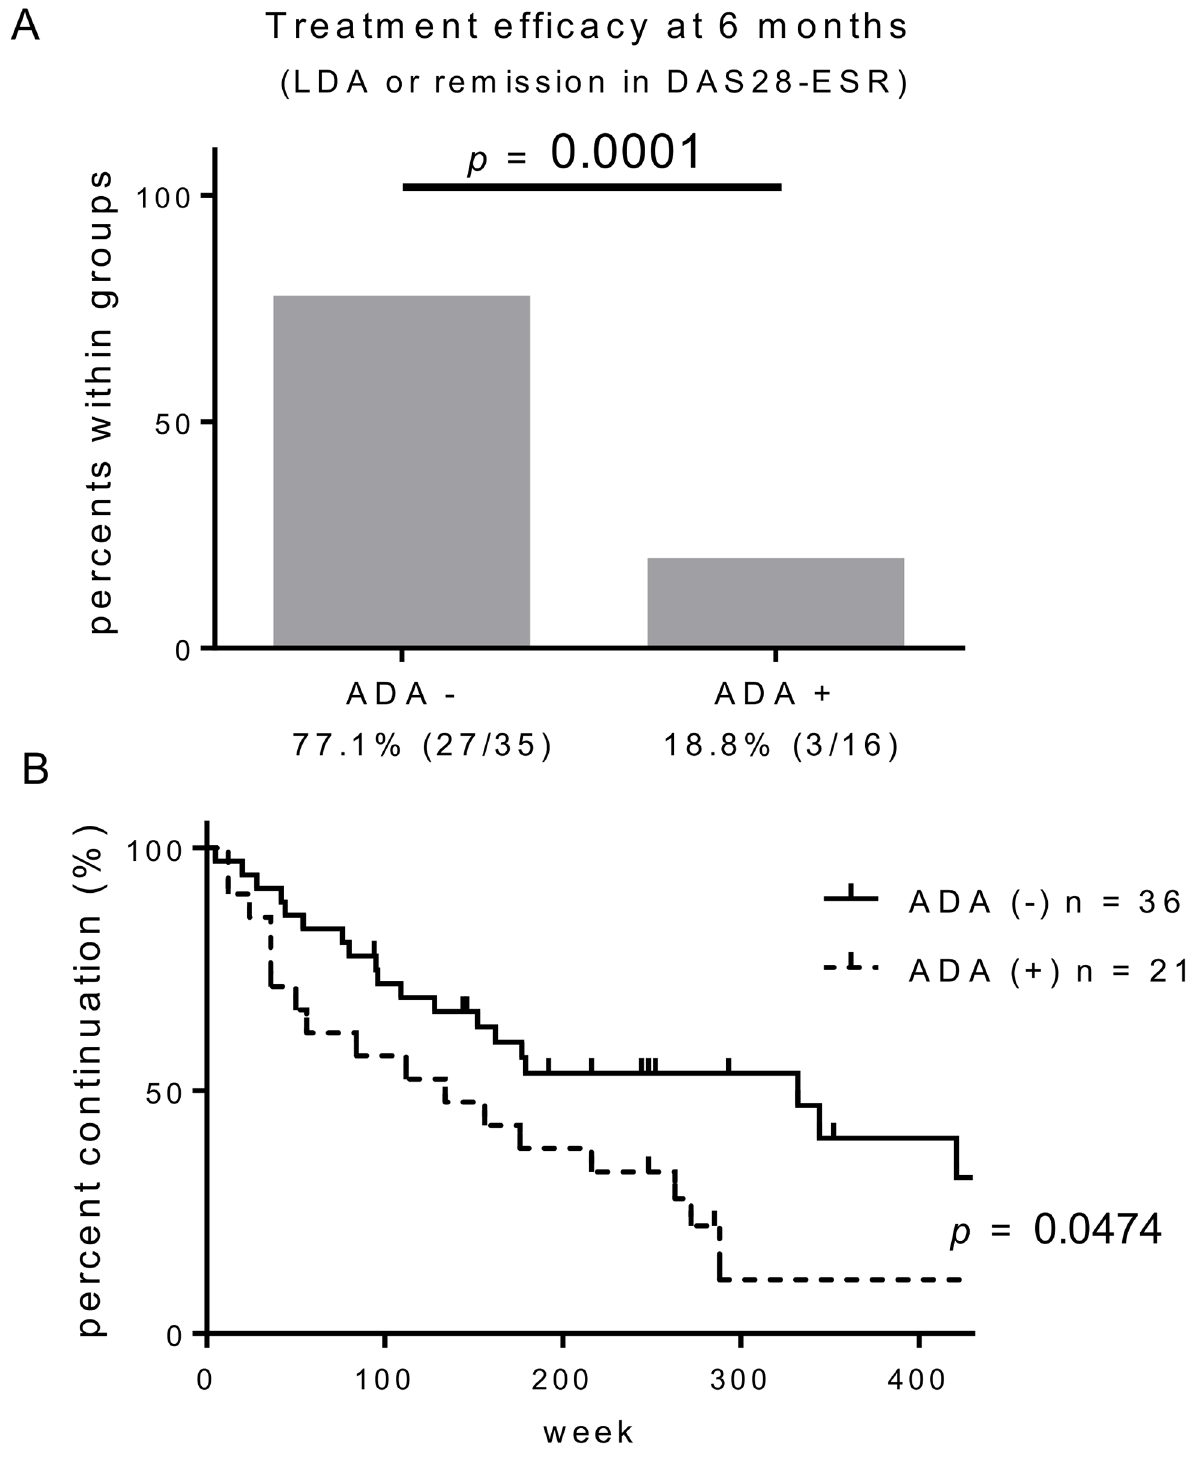
Fig 1. Anti-drug antibody (ADA) is associated with reduced clinical response. (A) Treatment efficacy defined as low disease activity (LDA) or remission at 6 months. Percentages and absolute numbers of each group of patients are indicated below the graphs. ADA positivity was based on the assessment of 6 months. Fisher ’ s exact test was used for comparison. (B) Cumulative drug retention rates. A log-rank test was used for comparison between the two groups.